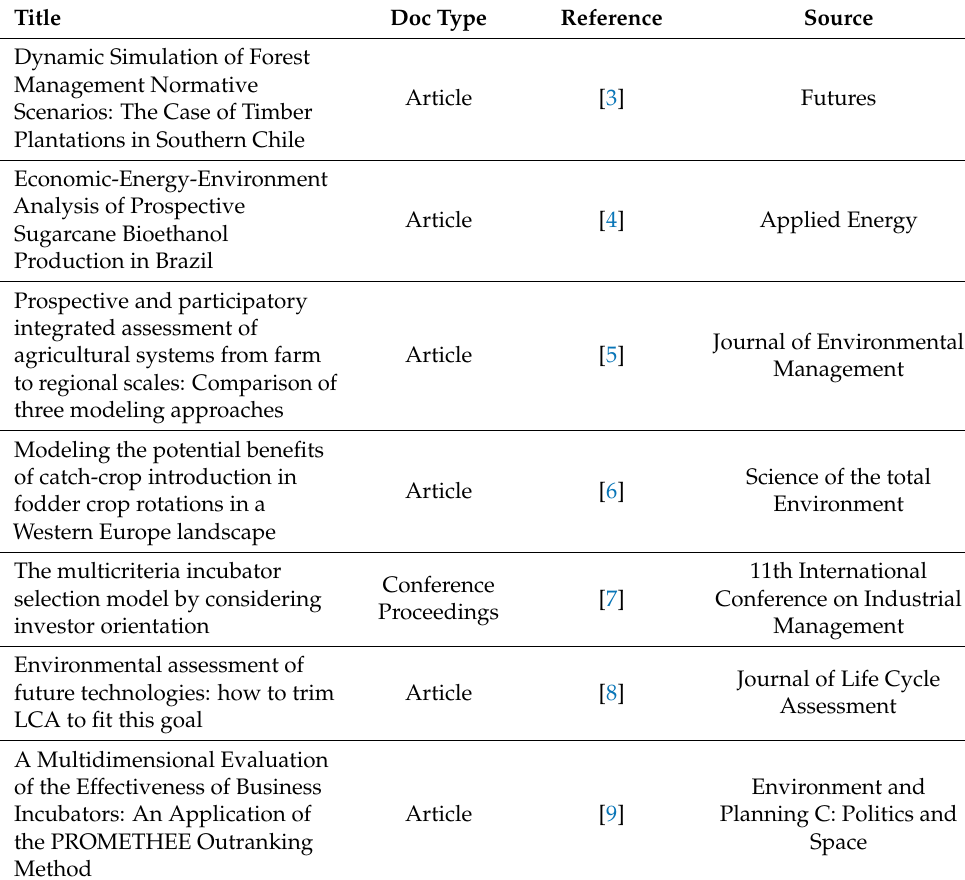
Table 2. Documents in the Scopus and Web of Science